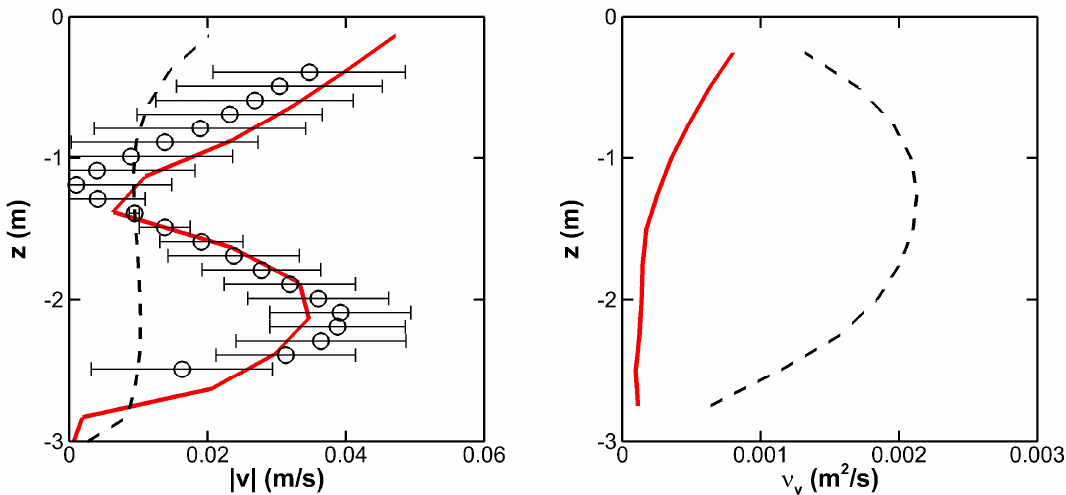
Figure 9. Model results of total horizontal velocity |v| and eddy viscosity ν ν profiles with (red solid line) and without (black dashed line) weak stratification effects. Measured total horizontal velocity profiles are denoted as circles with error bars.